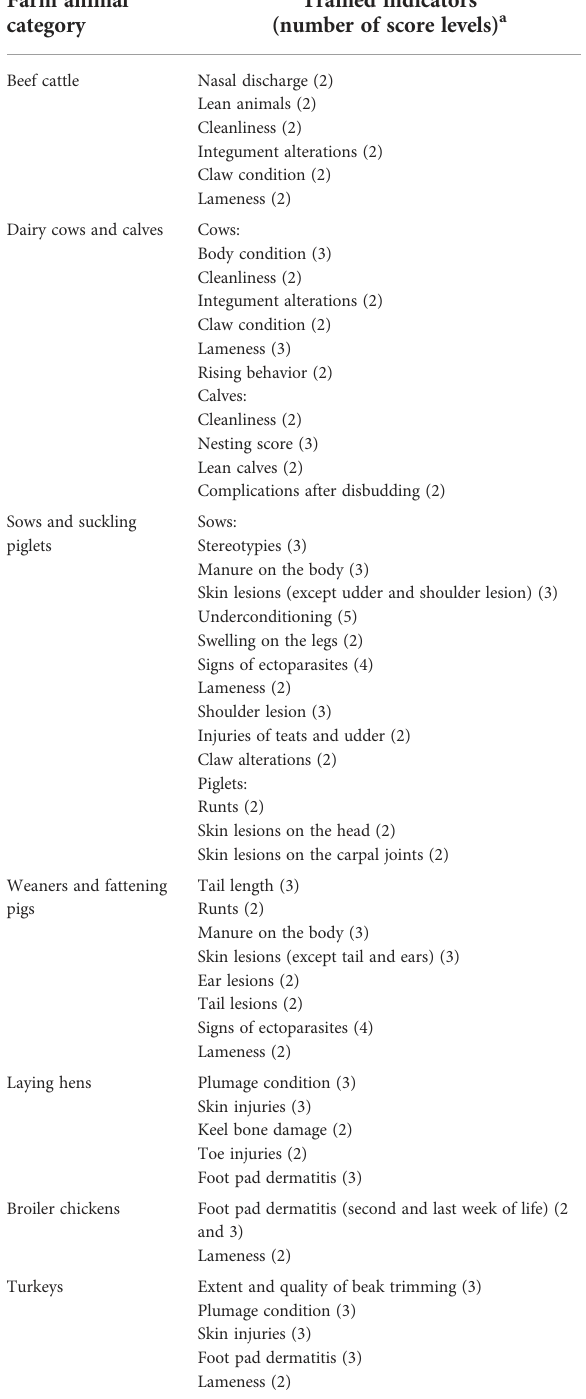
TABLE 1 Investigated animal-based indicators of the “ Animal Welfare Indicators: Practical Guide — Cattle/Pigs/Poultry ” (Brinkmann et al., 2016; Knierim et al., 2016; Schrader et al., 2016). Farm animal Trained indicators category (number of score levels)